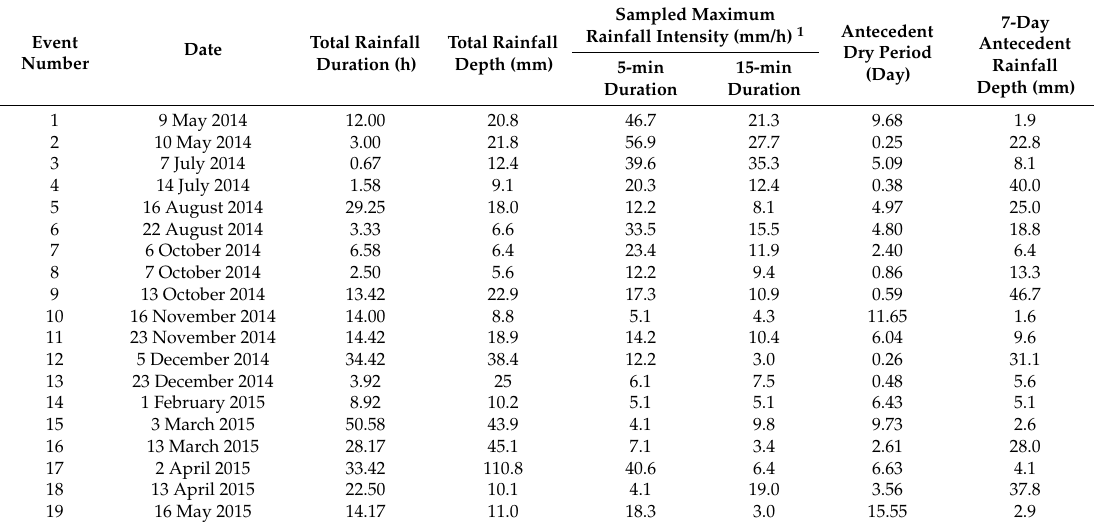
Table 3. Rainfall characteristics of storm events sampled for water quality